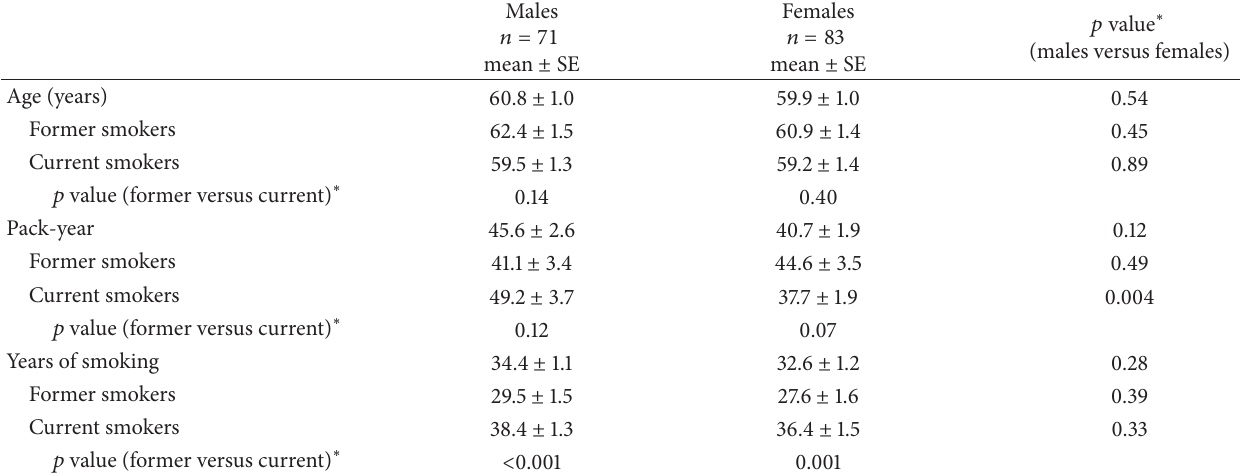
Table 1: Characteristics of the study population by gender and smoking status ( 𝑛 = 154).